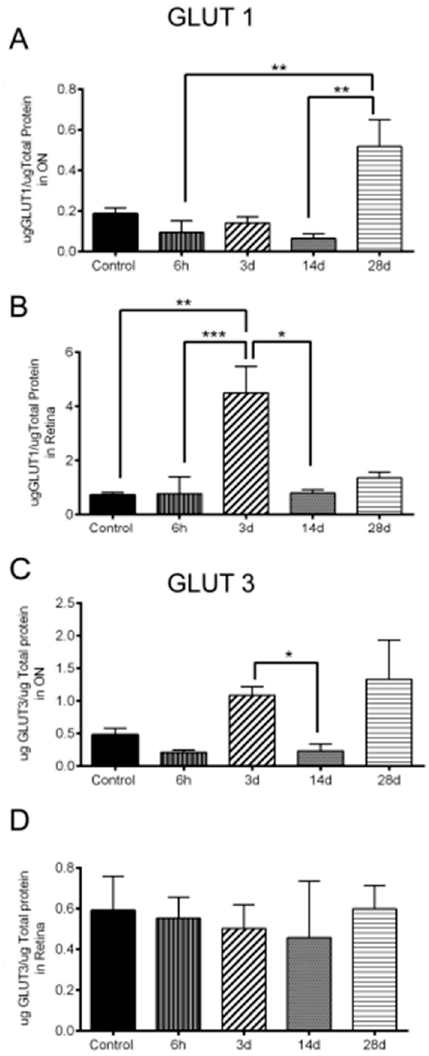
Figure 10. Significant changes in GLUT1 and GLUT3 levels after OHT. ( A ). Significant GLUT1 level increase in the ON 28 d after OHT compared to 6 h (**, p = 0.0094), and 14 d (**, p = 0.0059). n = 6 ONs at 6 h, 7 ONs at 3 d, 6 ONs at 14 d, 4 ONs at 28 d, and 18 control ONs. ( B ) Significant GLUT1 level increase in the retina 3 d after OHT compared to control (**, p = 0.0039), 6 h (***, p = 0.0008), and 14 d (*, p = 0.0488). n = 6 retinas at 6 h, 6 retinas at 3 d, 6 retinas at 14 d, 4 retinas at 28 d, and 18 control retinas. ( C ). Significant GLUT3 level increase in the ON 3 d after OHT compared to 14 d (*, p = 0.0426). n = 5 ONs at 6 h, 7 ONs at 3 d, 6 ONs at 14 d, 5 ONs at 28 d, and 19 control ONs. ( D ). No significant change in GLUT3 level in the retina 6 h, 3 d, 14 d, and 28 d after OHT ( p > 0.05). n = 9 retinas at 6 h, 11 retinas at 3 d, 6 retinas at 14 d, 4 retinas at 28 d, and 18 control